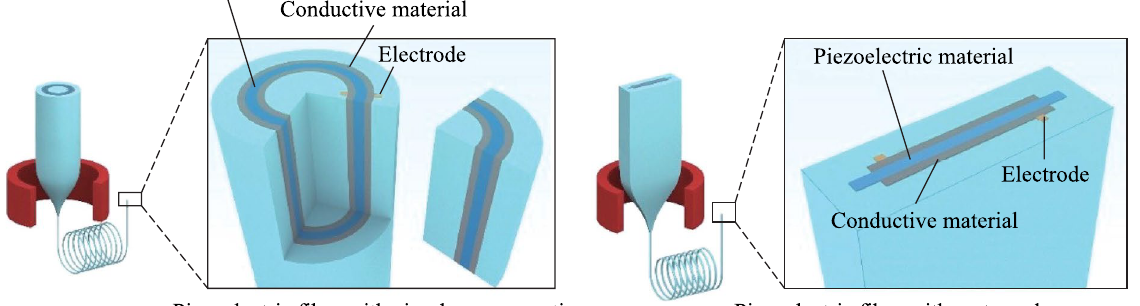
Fig. 3 Schematic representations of thermally drawn piezoelectric fibers with a circular structure and b rectangular